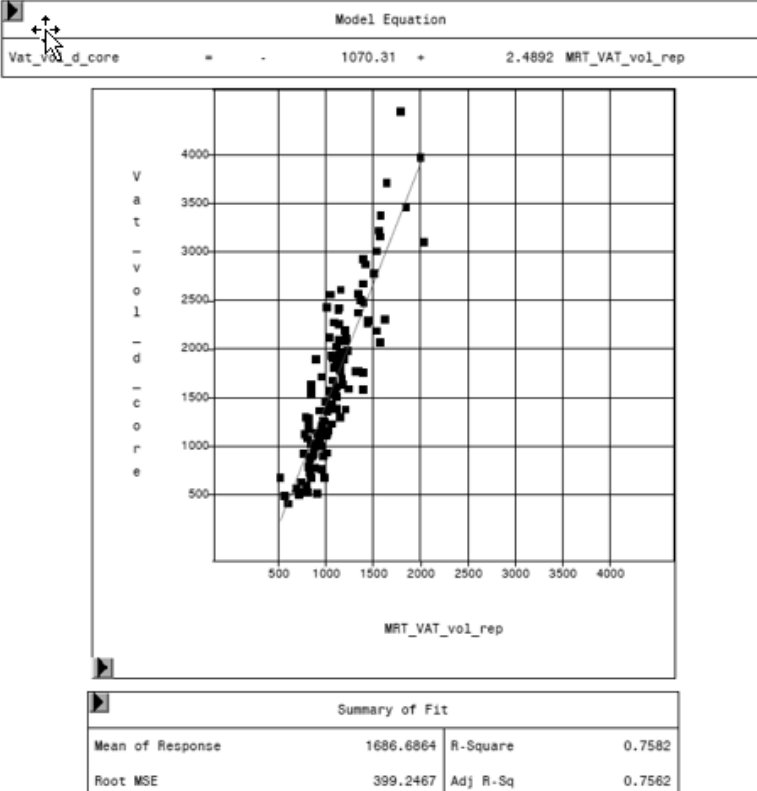
Figure 8. Relationship between volume of VAT measured by MRI (MRT_VAT_vol_rep, in cm 3 ) and DXA “thick” mode (VAT_vol_d_core, in cm 3 ). Animals 2020 , 10 , x FOR PEER REVIEW Table 4. Relationship between volume of VAT measured by MRI (MRT_VAT_vol_rep) and DXA “thick” mode and DXA “standard” mode.